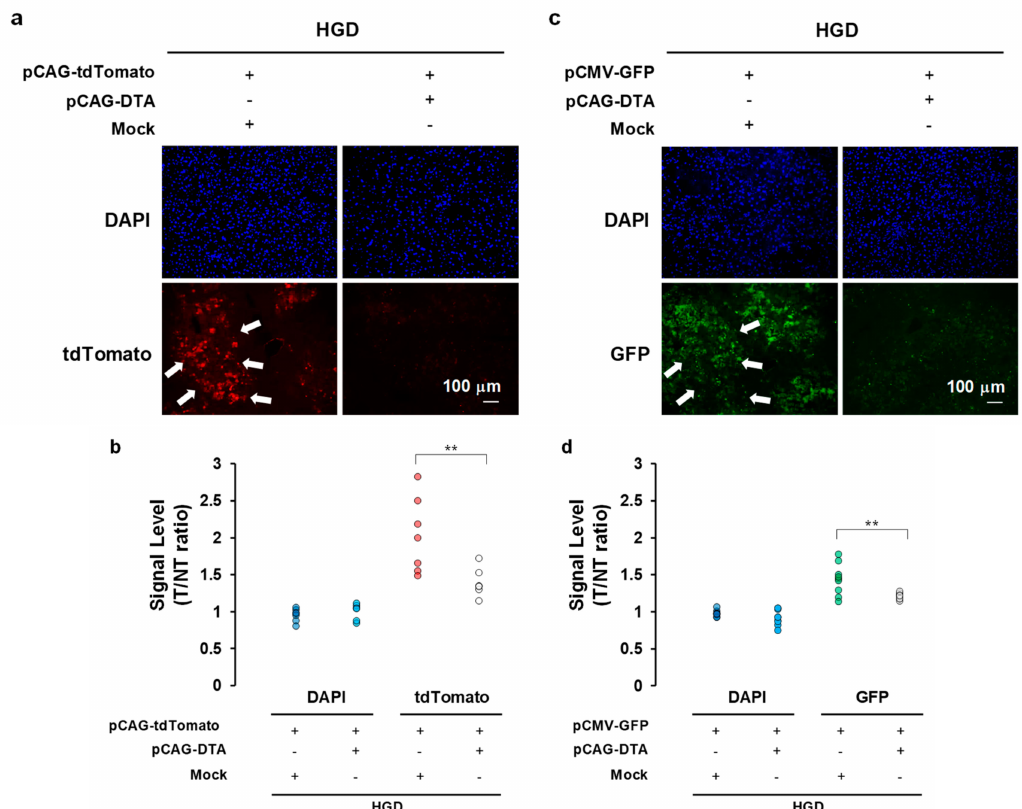
Figure 2. E ff ect of DTA on protein synthesis inhibition. ( a ) E ff ect of DTA on tdTomato expression in mice hepatocytes 12 h after the hydrodynamic gene delivery of pCAG–tdTomato with pCAG–DTA. ( b ) A quantitative analysis of tdTomato signal level determined with the ratio of the signal (T / NT ratio) in the transfected (T) liver and non-transfected (NT) liver collected from the mock transfected liver. ( c ) E ff ect of DTA on green fluorescent protein (GFP) expression in mice hepatocytes 12 h after the hydrodynamic gene delivery of pCAG–tdTomato with pCAG–DTA. ( d ) A quantitative analysis of the GFP signal level determined with the T / NT ratio. White arrows indicate expression of tdTomato and GFP. Scale bar represents 100 µ m. The values from the two sections of three mice are shown. ** p <